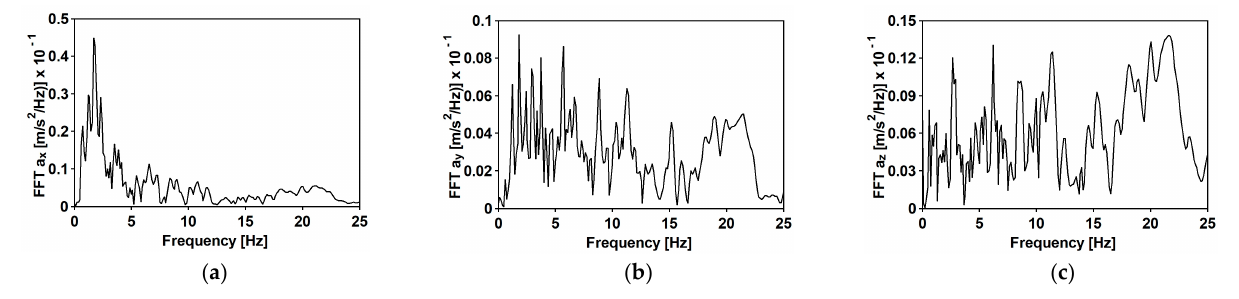
Figure 10. Fourier spectra of the second mining-induced shock: ( a ) horizontal direction WE; ( b ) horizontal direction NS; ( c ) vertical direction Z.